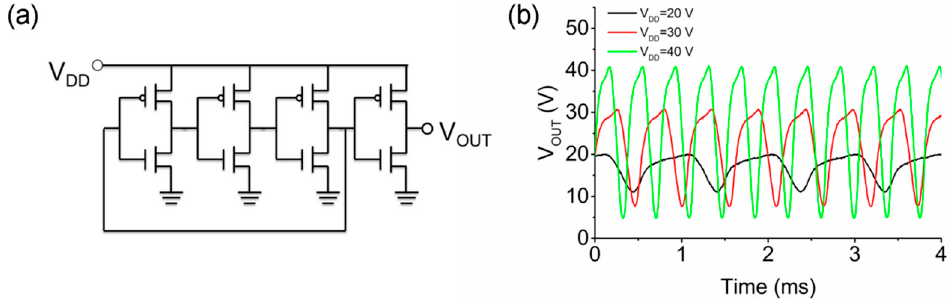
Table 2. Properties of the three-stage complementary ring oscillator.